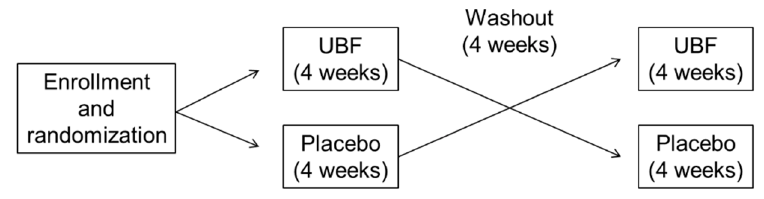
Figure 1. Scheme of the study protocol. UBF—unripe banana flour.